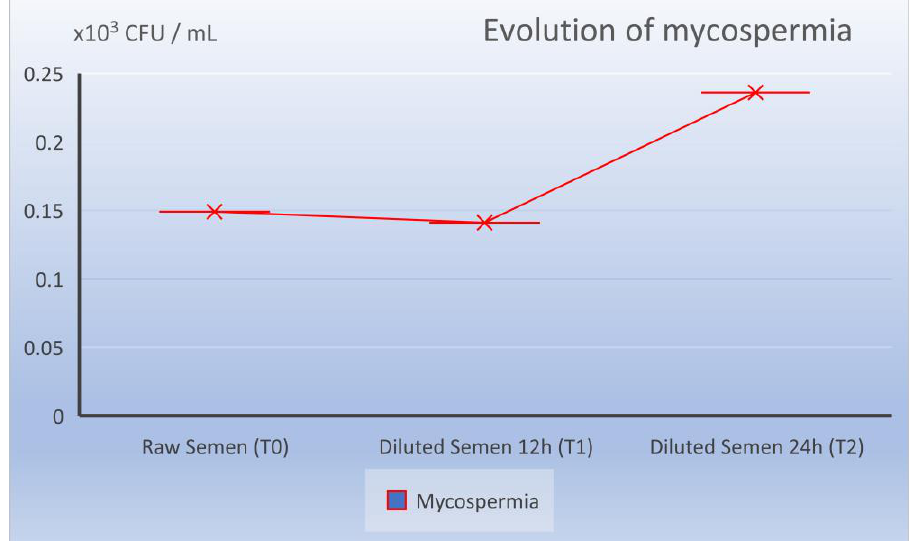
Figure 5. Evolution of mycological load in the dynamics from ejaculate collection (T0), 12 h after dilution (T1), and 24 h preservation (T2).